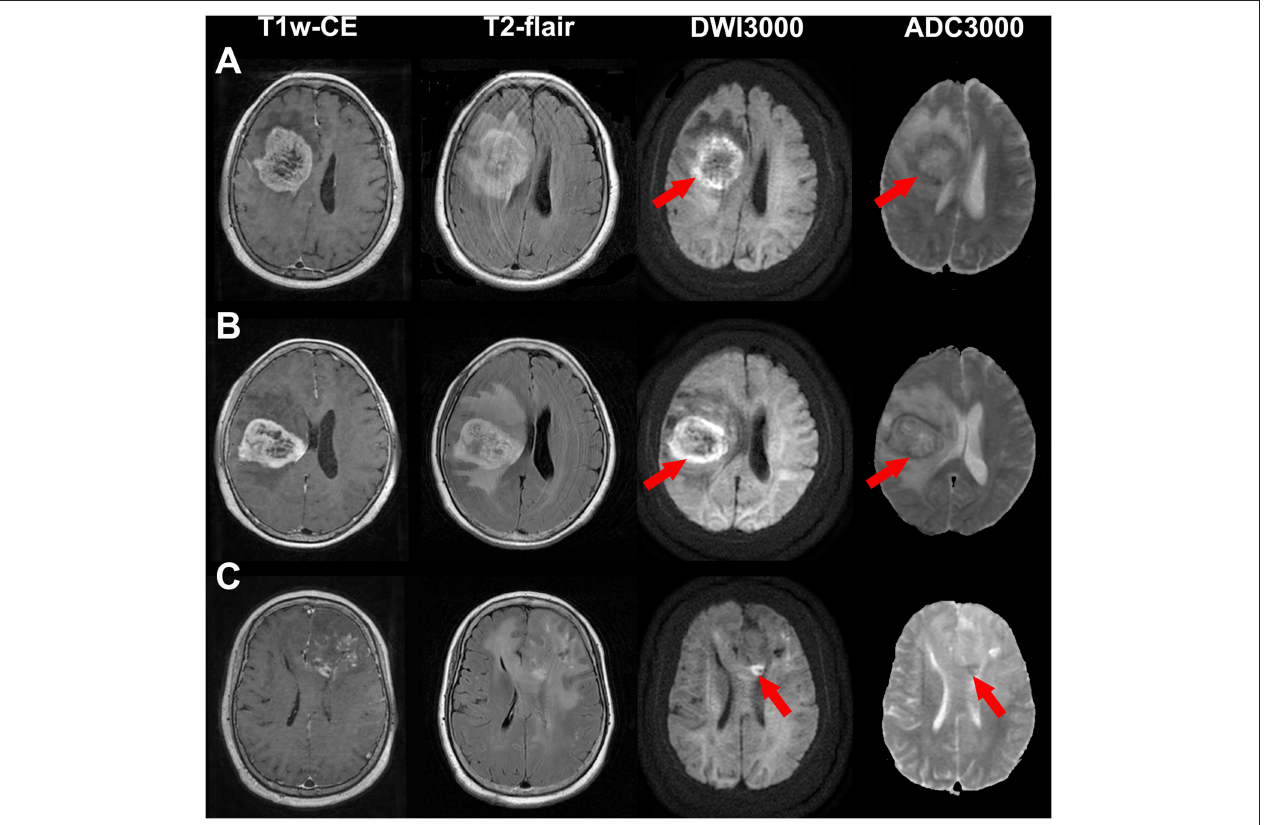
FIGURE 1 | Illustrations of a glioblastoma (WHO grade IV) (A) , an anaplastic astrocytoma (WHO grade III) (B) and an astrocytoma (WHO grade II) (C) with bright edge sign. T1-weighted contrast-enhanced images, T2-flair contrast-enhanced images, DWI maps with b = 3,000 s/mm 2 and ADC maps with b = 3,000 s/mm 2 are shown in the first to forth rows, respectively. Red arrows show the extremely high signal regions in tumor margins on DWI maps. Note that the ADC values of these regions are low.